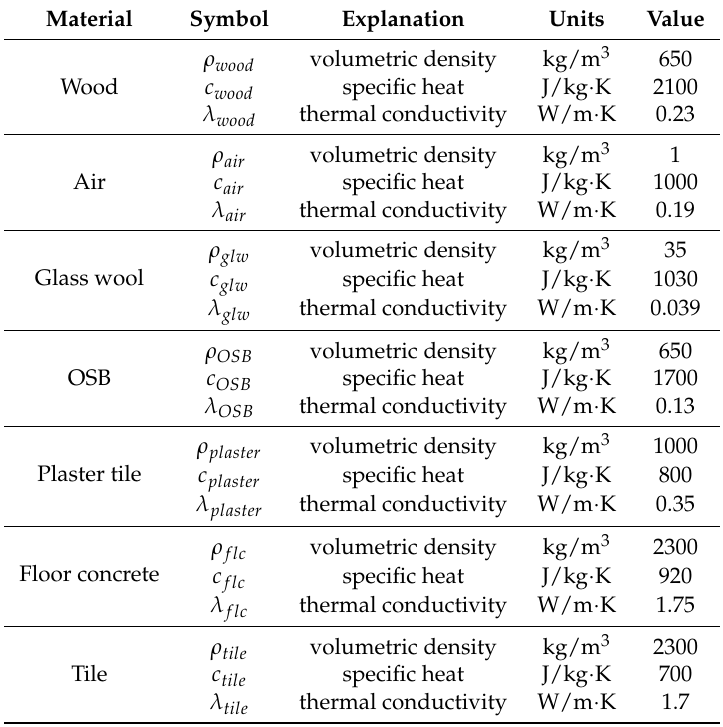
Table 2. Thermal characteristics of house envelope components.